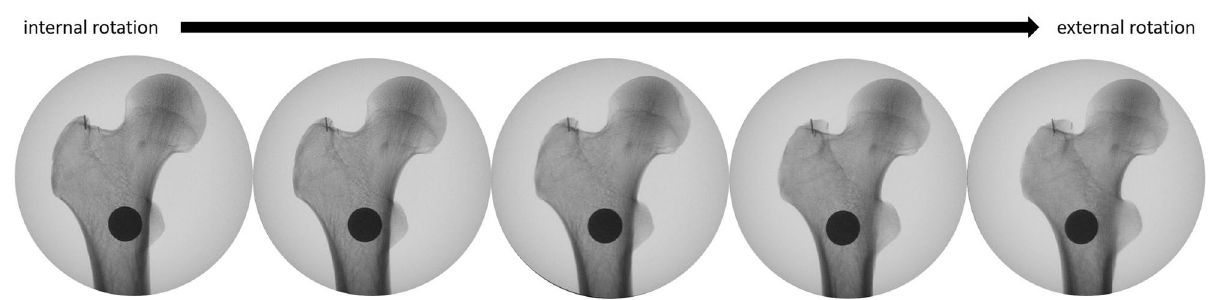
Figure 3. Radiological image sets. Images were attained at various angles as the c-arm was rotated in 5° intervals from internal to external